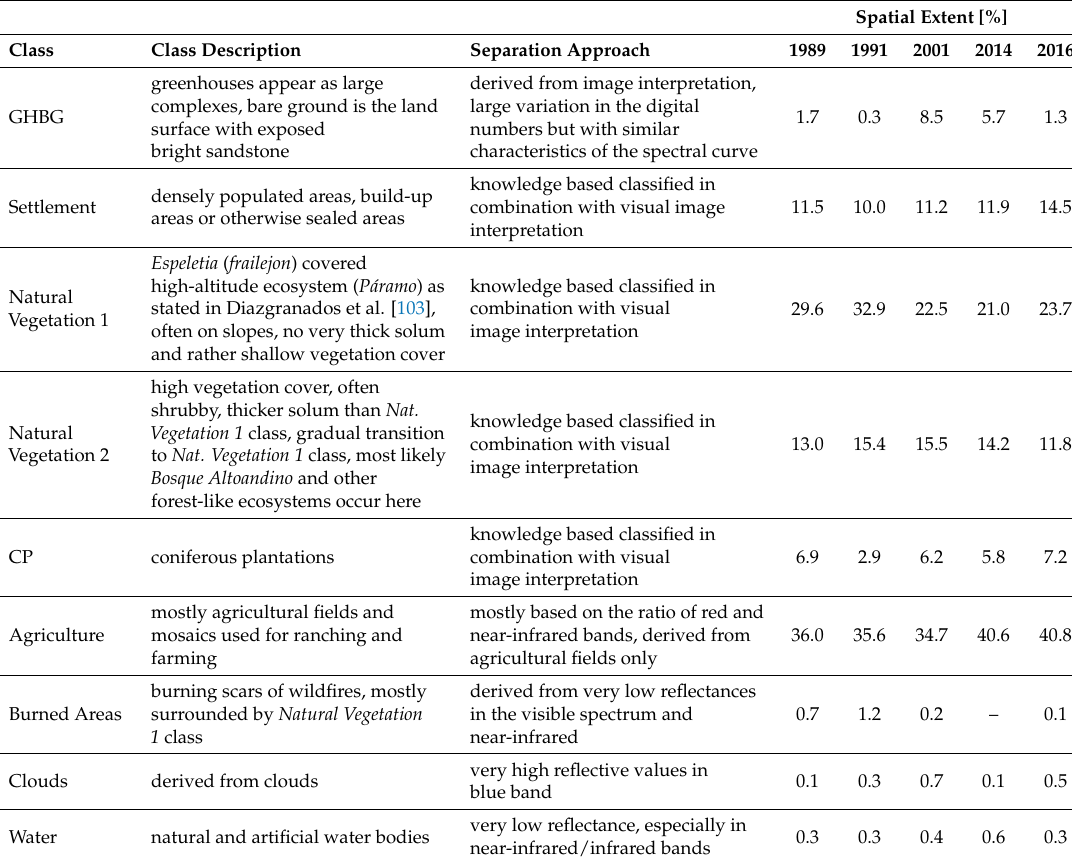
Table 2. Class description, class separation approach and relative spatial share of each land cover class from 1989 to